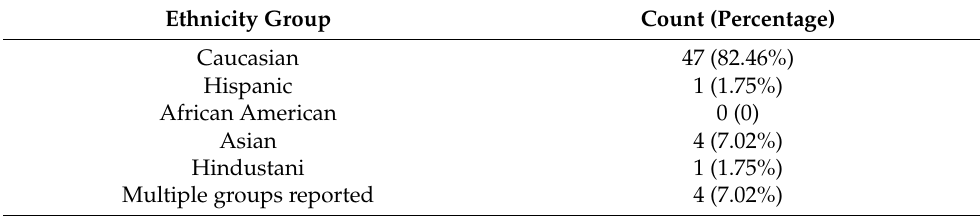
Table 1 for an overview of ethnicity distributions), with a mean age of 20.88 ( SD = 2.63). Accuracy on the responded trials in the dual-probe task was high in this final sample, with a mean of 94.77% ( SD = 4.61). The mean attentional bias to alcohol index score in the sample was 48.97 ( SD = 9.40), and the mean reported change in subjective craving for beer